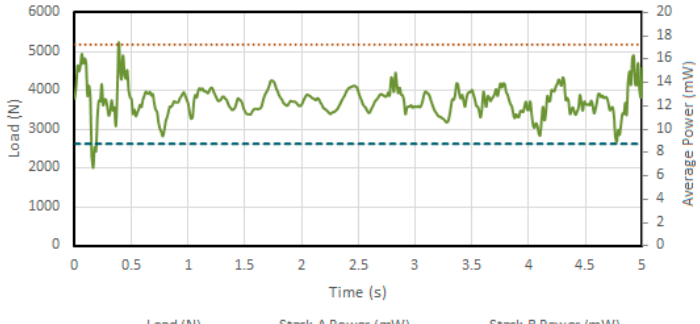
Figure 3. Measured force applied to a platform support with pedestrian traffic, and the output power of each piezoelectric